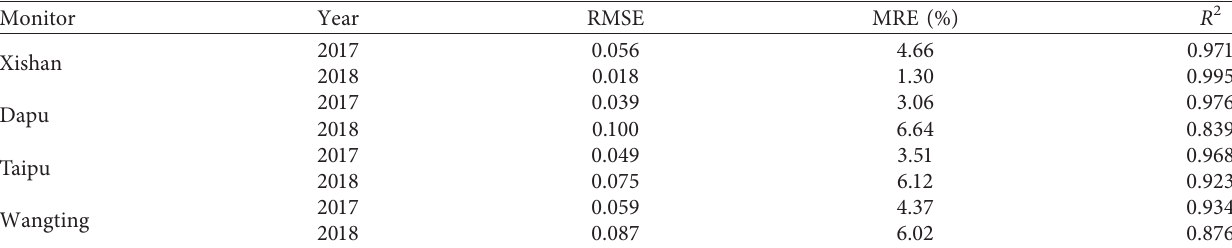
Table 1: Model calculation evaluation.